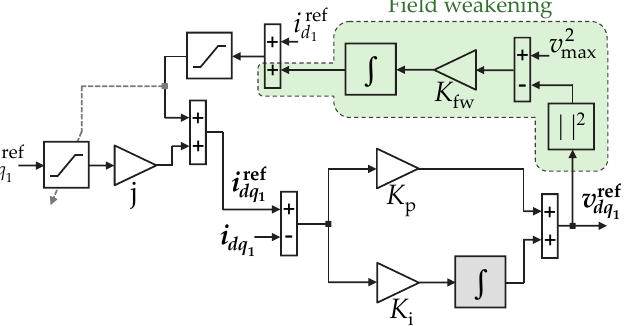
Figure 31. Field weakening for RFOC synchronous PI current control in α 1 - β 1 plane, as for n = 3 [560]. The maximum steady-state voltage-reference modulus v max usually matches the radius of a circumference inscribed in the α 1 - β 1 output-voltage boundary. Instead of squared voltage values before K fw , a square root may be applied [7], at the cost of more computations [560]. Anti-wind-up (not shown) may also be needed for the integrator in the field-weakening feedback